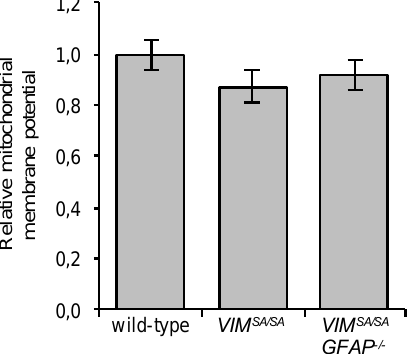
Figure 6. Immature VIM SA / SA and VIM SA / SA GFAP − / − astrocytes have normal mitochondrial membrane potential. The mitochondrial membrane potential was measured by using the TMRE probe. Immature wild-type, VIM SA / SA , and VIM SA / SA GFAP − / − astrocytes were incubated for 2 h in PBS and 30 min with TMRE. N = 7, 7, and 6, respectively.